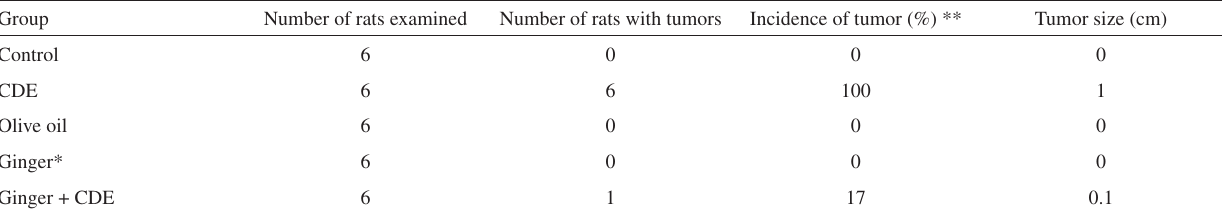
Table 1 - Effect of Ginger on the incidence of liver neoplasms in ethionine induced rat hepatocarcinogenesis. The forma- tion of preneoplastic liver nodules was induced in rats by feeding them with a choline-deficient diet supplemented with